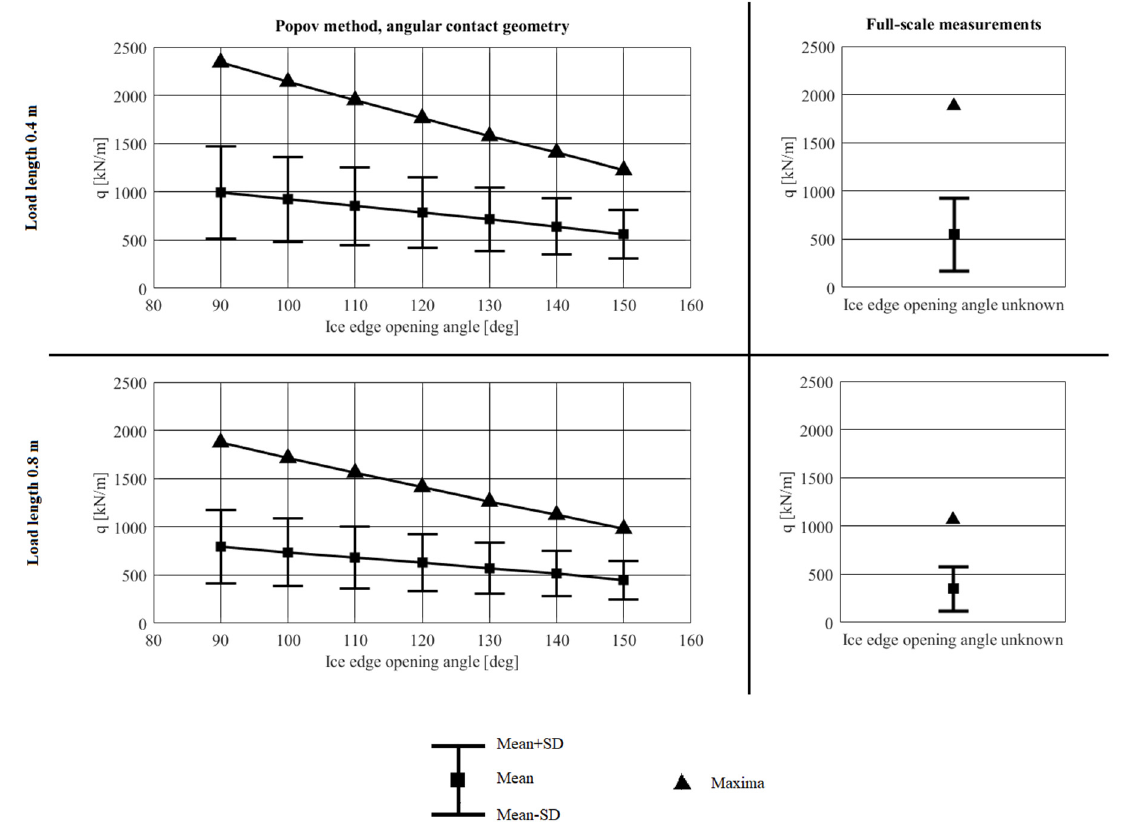
Figure 11. Comparison of line loads from the Popov Method for di ff erent ice edge opening angles of angular contact geometry.